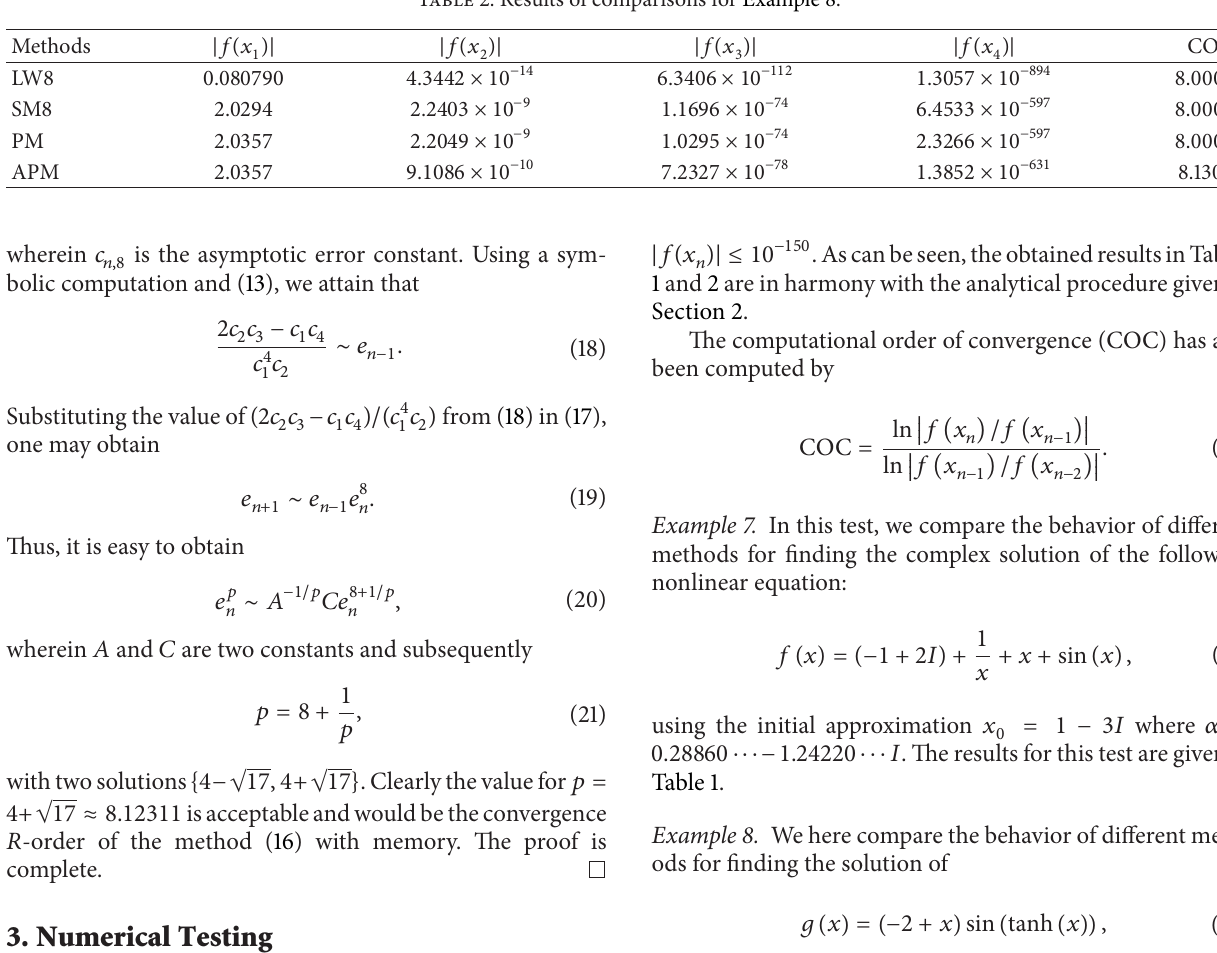
Table 2: Results of comparisons for Example